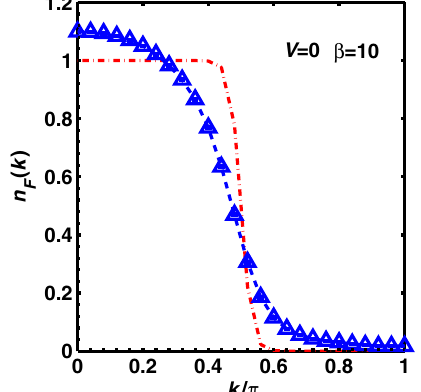
FIG. 4. The on-site particle number fluctuation δ defined in Eq. (10). The parameters are β ¼ 6 , J ¼ 2 , and L ¼ 30 .